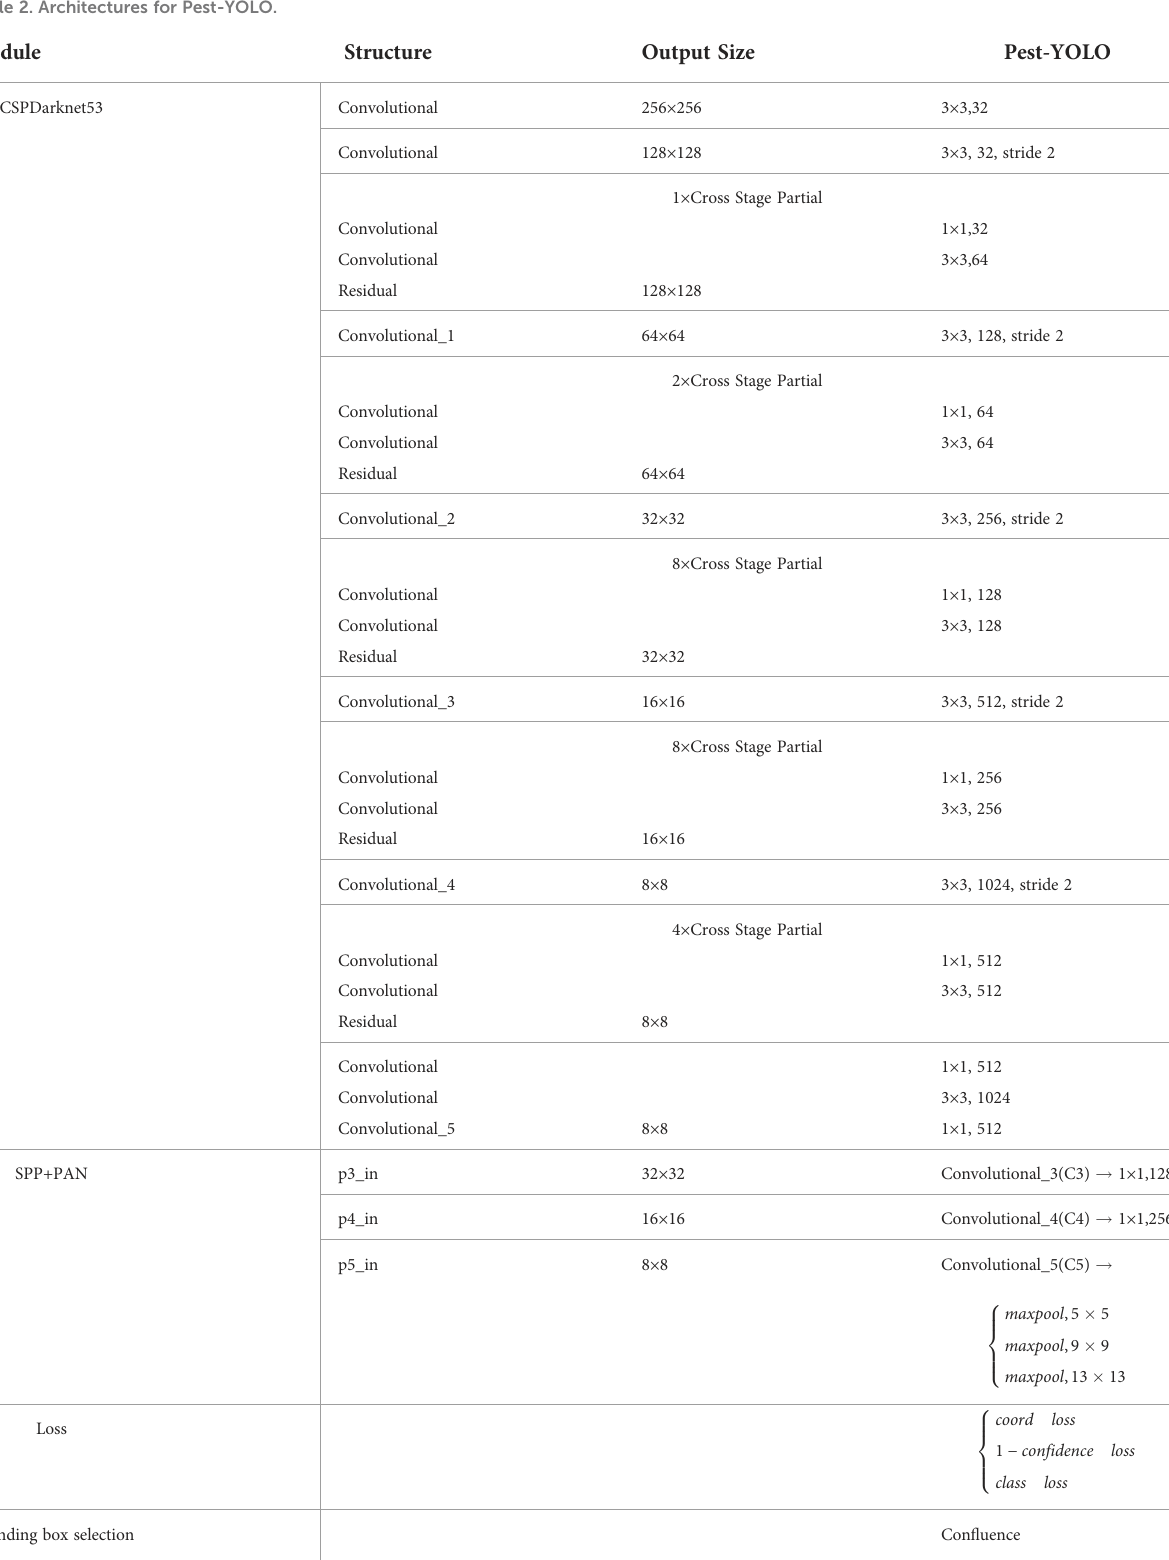
Table 2. Architectures for